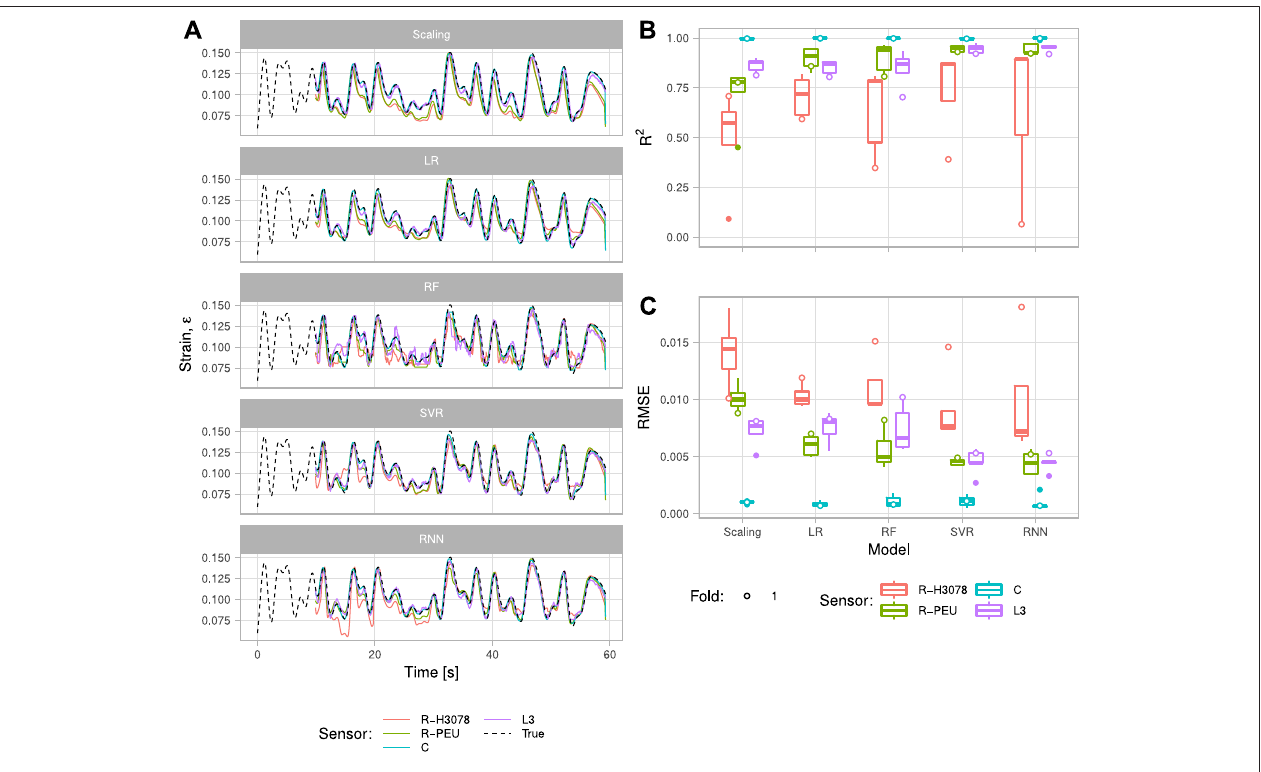
FIGURE 7 | Output traces (A) and performance (B) , (C) of the regression models trained on random strain data for each sensor type. (A) Strain estimated by each modelforeachsensortype(solid)andtheactualstrain(dashed)duringtherandomstraintest. (B) Boxplotsofthecoef fi cientofdeterminationforthefoursensorsand fi ve regression models. Boxes indicate interquartile range (IQR) and whiskers extend to the smallest and largest observations that are up to 1.5 IQR from the boxes. Outliers are denoted with fi lled circles while goodness of fi t values for the fi rst fold, which often had poor results, are shown with open circles regardless of whether or not they are an outlier. (C) Box plots of the root mean squared error for the four sensors and fi ve regression models.